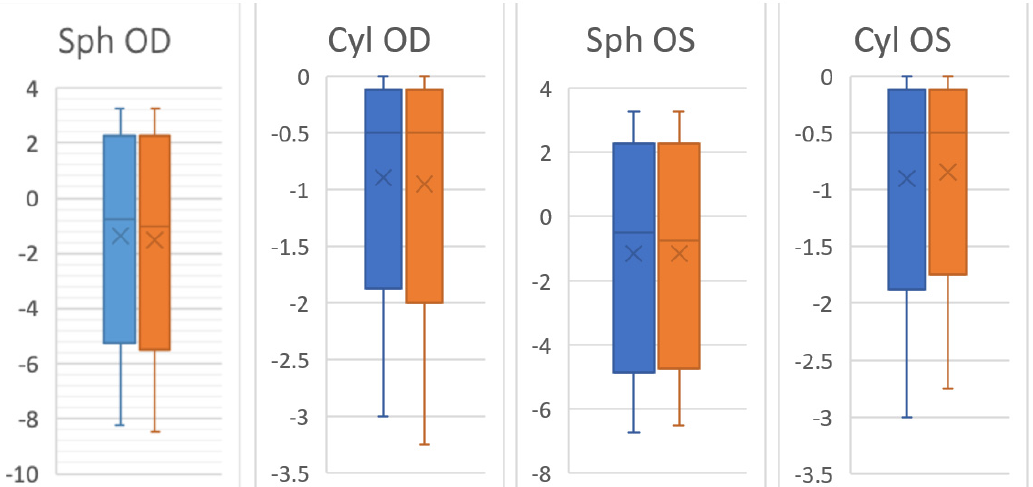
The maximum value for astigmatism is always 0, since it corresponds to the condition of a non-astigmatic eye. It can be noted that the data relating to “seated” measurements were slightly more dispersed for the right eye but less dispersed for the left eye. This is also confirmed by Figure 2.